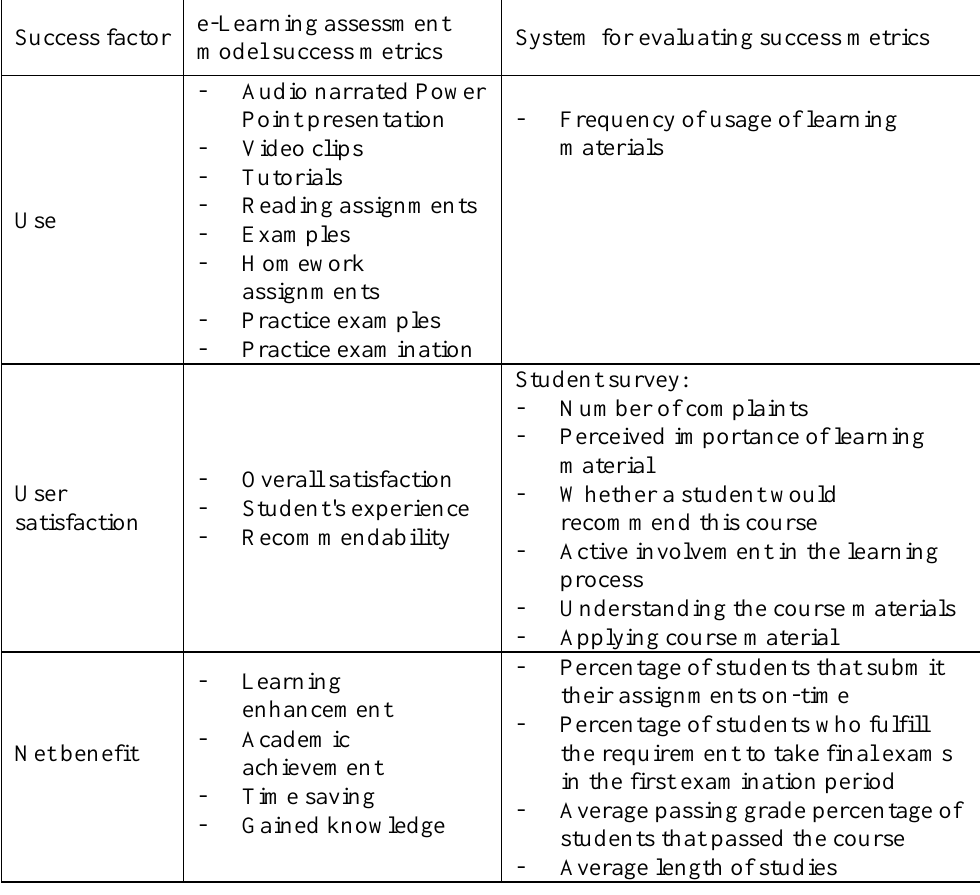
e-Learning Success Metrics for Use, User Satisfaction, and Net Benefits Success